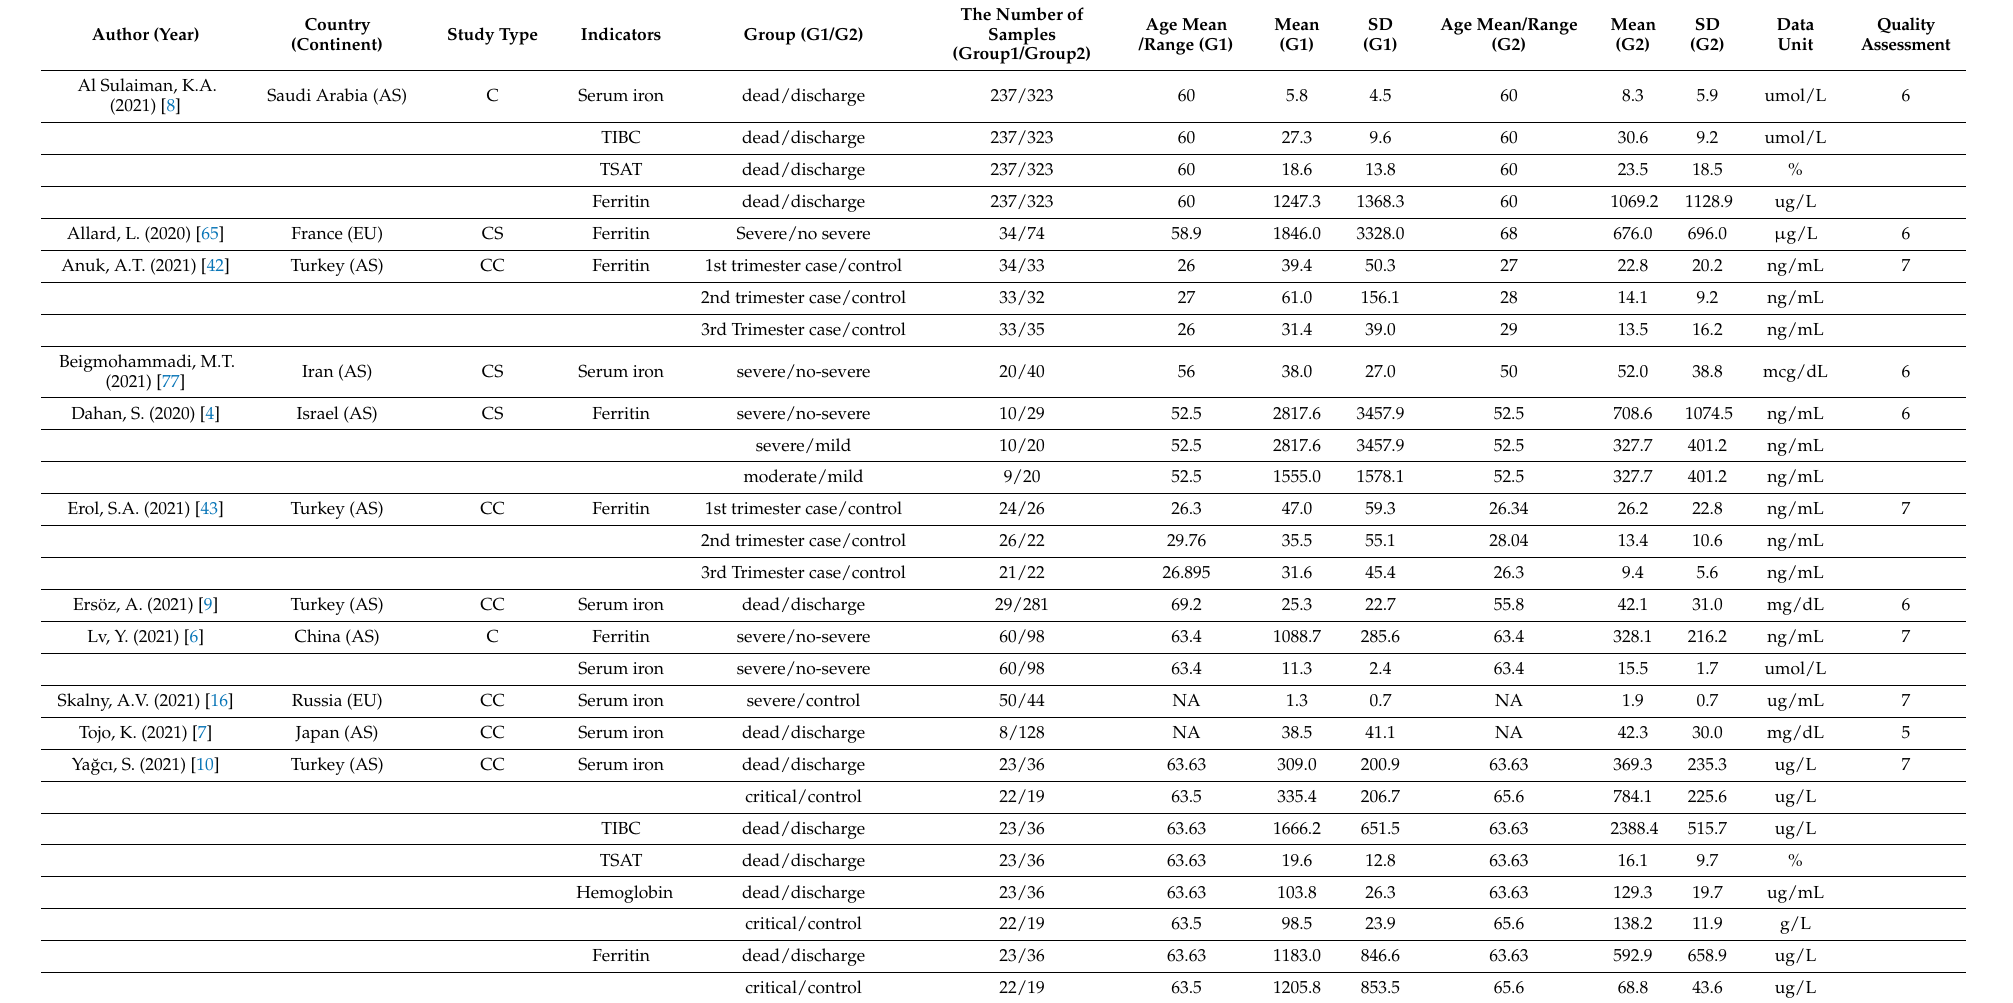
Table 1. Characteristics of 72 included studies of iron-related